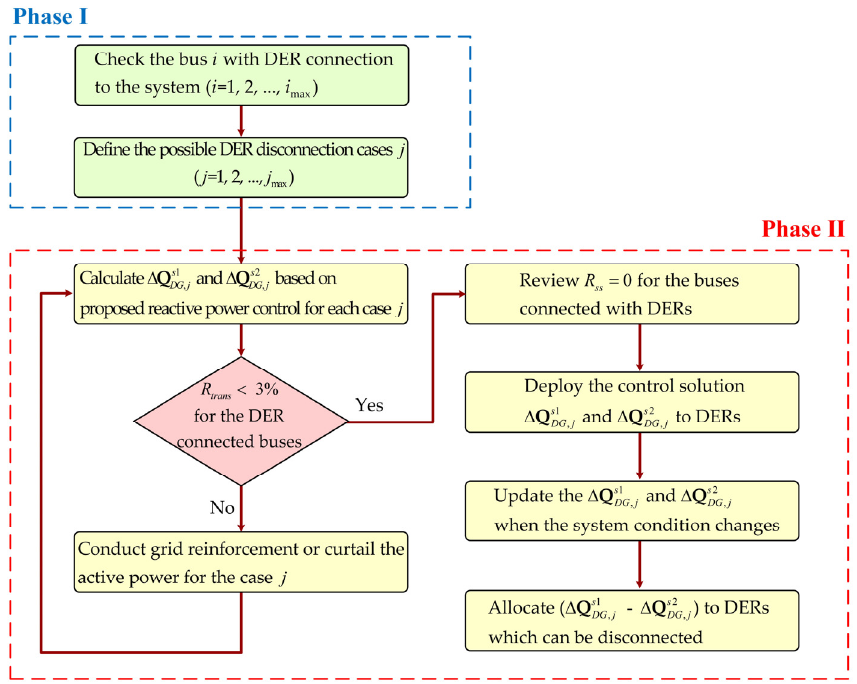
Figure 1. Implementation of the proposed reactive power management method.